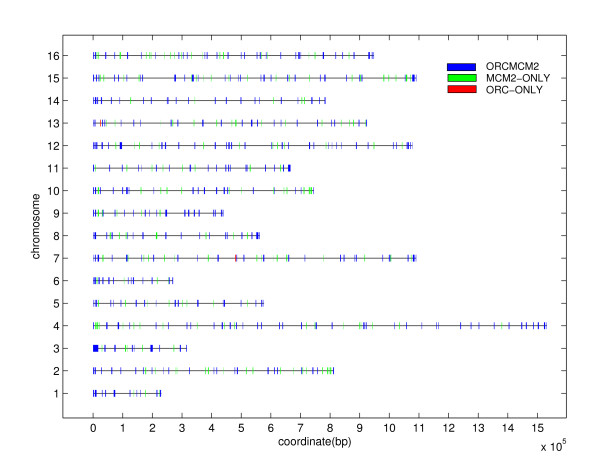
Distribution of nimARSs along the 16 S. cerevisiae chromosomes. Each horizontal line represents one chromosome. Blue bars represent nimARS sites identified by both ORC and MCM2; green bars represent nimARS sites identified by MCM2 only; and red bars represent nimARS sites identified by ORC only.